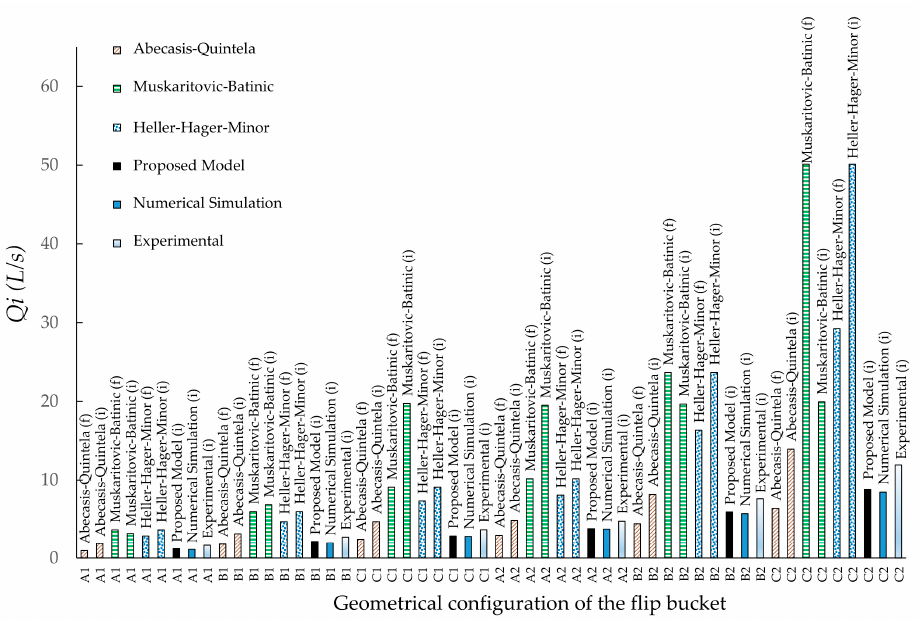
Figure 17 . Flow rate for the initiation of the jet flow Qi obtained using the formula of various authors, the proposed formula, numerical modeling and physical models in the